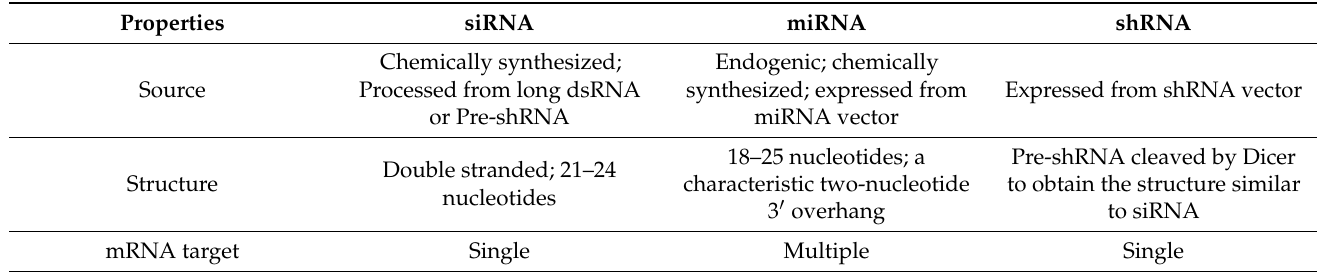
Table 2. Comparison of general properties among siRNA, miRNA, and